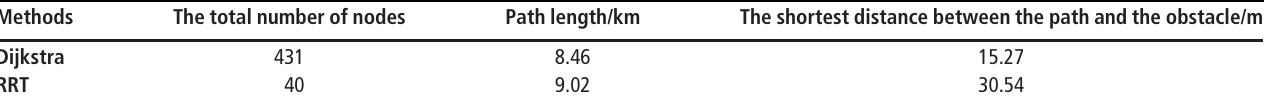
Table 3 Path planning results under different methods